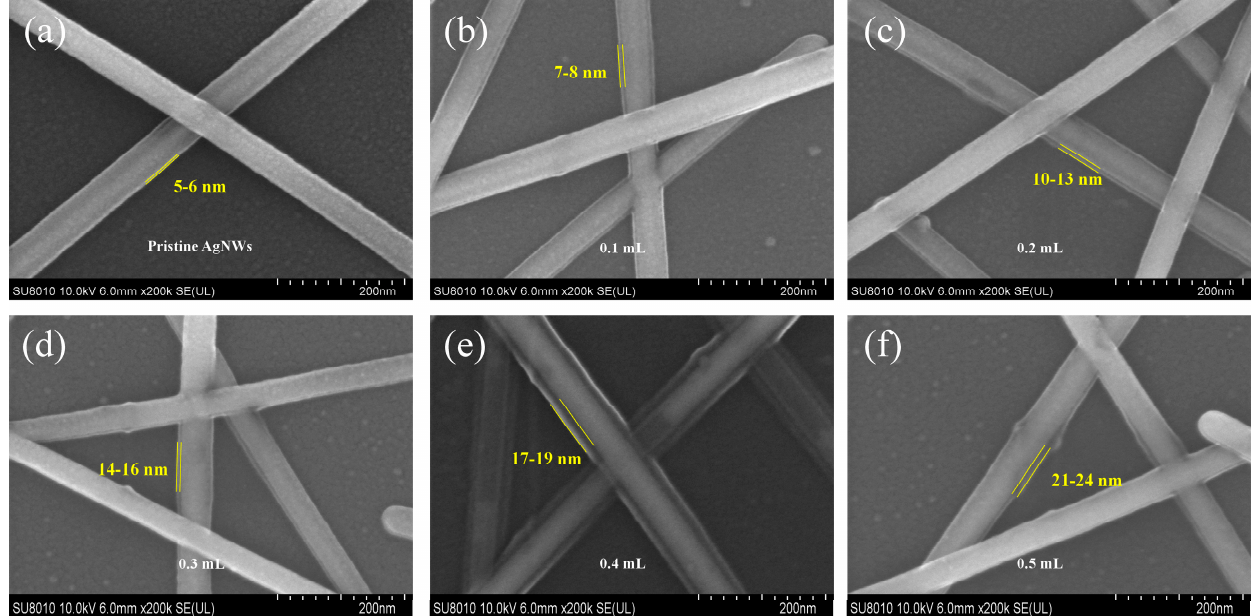
Figure 7. SEM images of PVP wrapping on the surface of AgNWss: ( a ) pristine AgNWss; ( b – f ) PVP precipitation thickness on the surface of AgNWss treated with different water moisture amounts for ( b ) 0.1 mL, ( c ) 0.2 mL, ( d ) 0.3 mL, ( e ) 0.4 mL and ( f ) 0.5 mL.